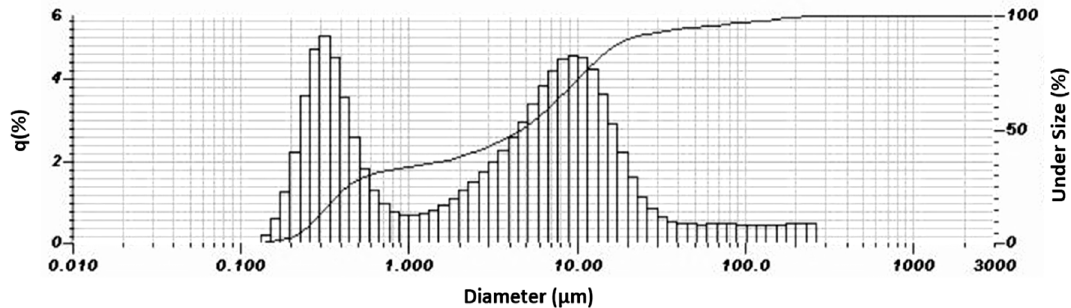
Figure 3. Particle size analysis of the used MCW.